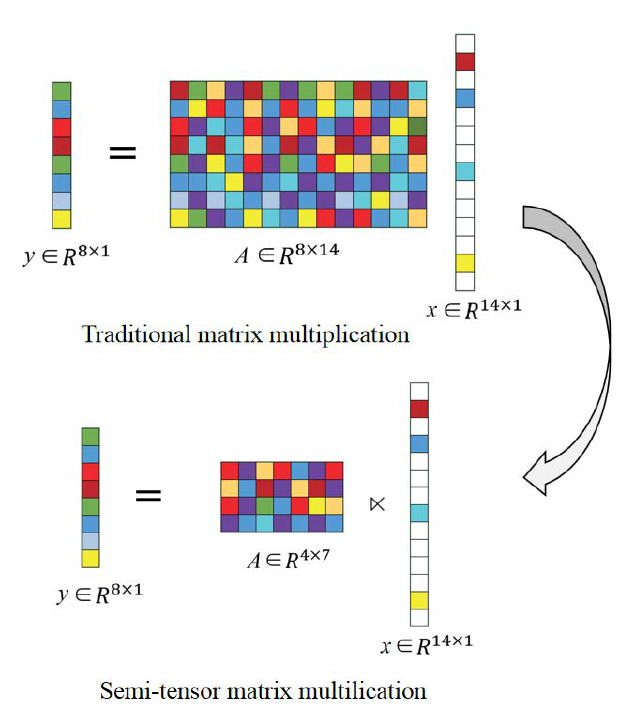
Figure 3. Difference between traditional matrix multiplication and semitensor matrix multiplication. Traditional matrix multiplication should meet limitations of matrix dimensions. Column number in matrix A must be equal to row number in matrix x . The theory of semitensor product (STP) breaks through this limitation, able to perform matrix multiplication when two matrices do not meet the dimension-matching condition